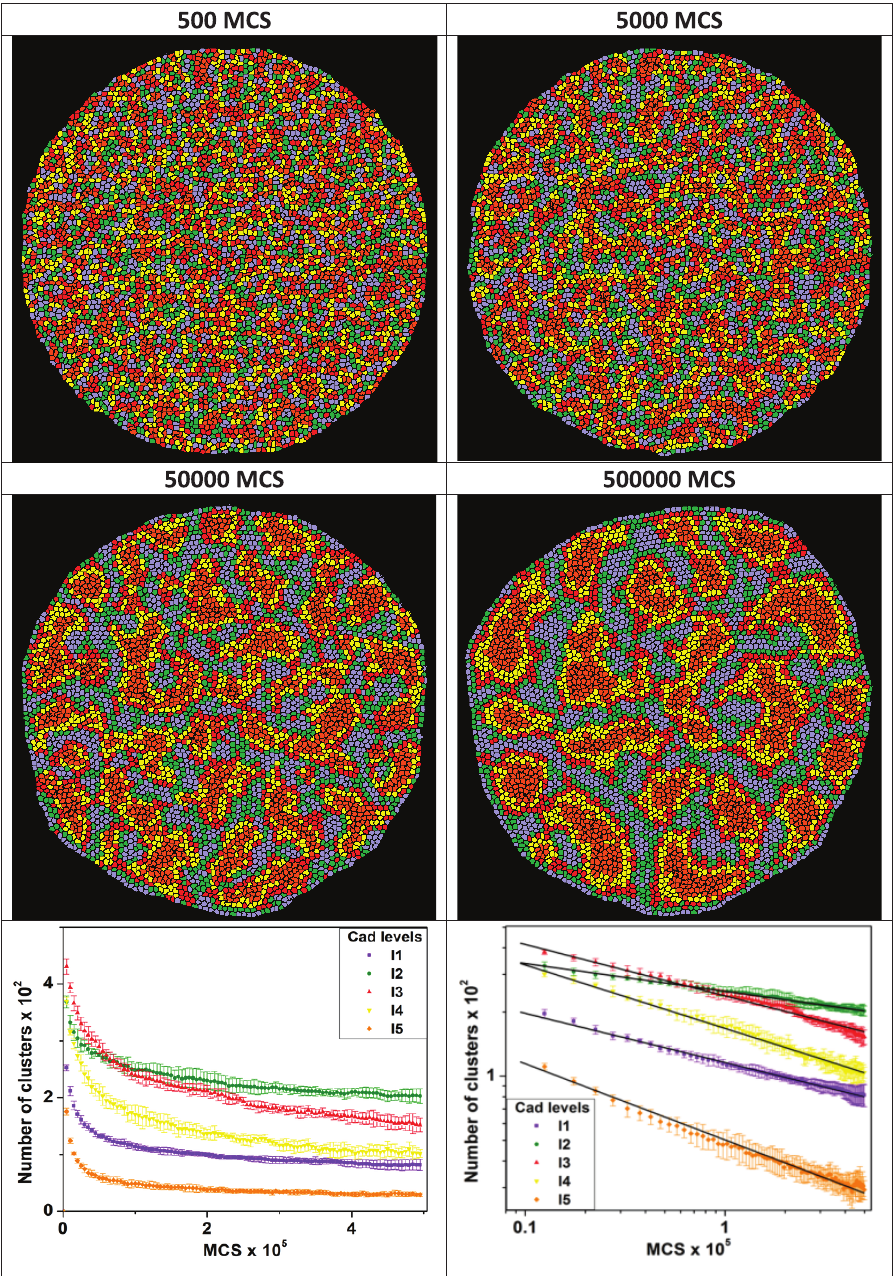
Figure 8. Clustering dynamics. First and second rows: snapshots taken from a 5000 cell aggregate simulation with five levels of cadherins [1(l1), 6.5(l2), 12(l3), 17.5(l4), 23(l5)] showing the dynamics of cluster formation. Bottom row: the left graph shows the evolution of the number of cluster for each cadherin level. The log-log graph (right) shows that the dynamics is adequately fitted by a power law of at b , as indicated by the black lines. The error bars in the graphs are calculated from six simulation